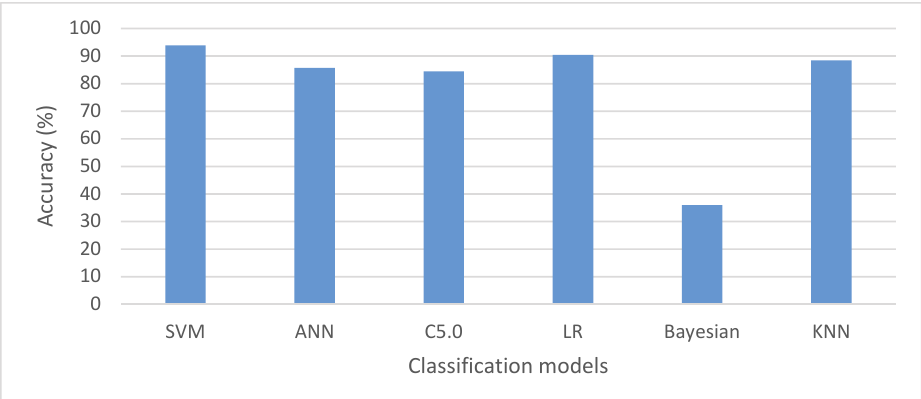
Fig. 10. Accuracy results of the classification models in situation